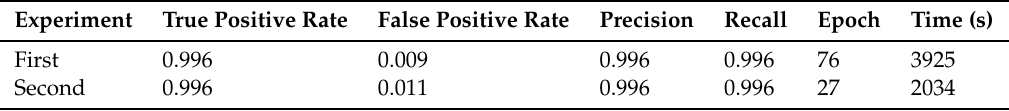
Table 3. Details of the results for two